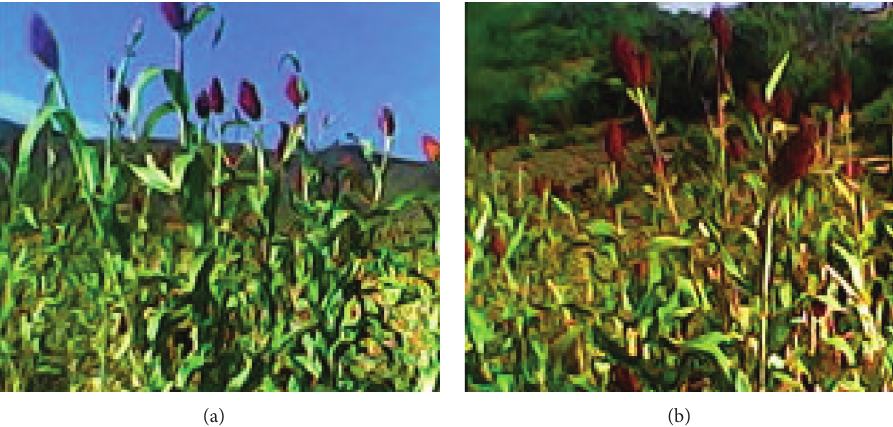
Figure 5: Agroecology of farmers’ sorghum field: (a) Tenta and Delanta; (b) Mekdela districts. Source: local farmer’s field during field visit,